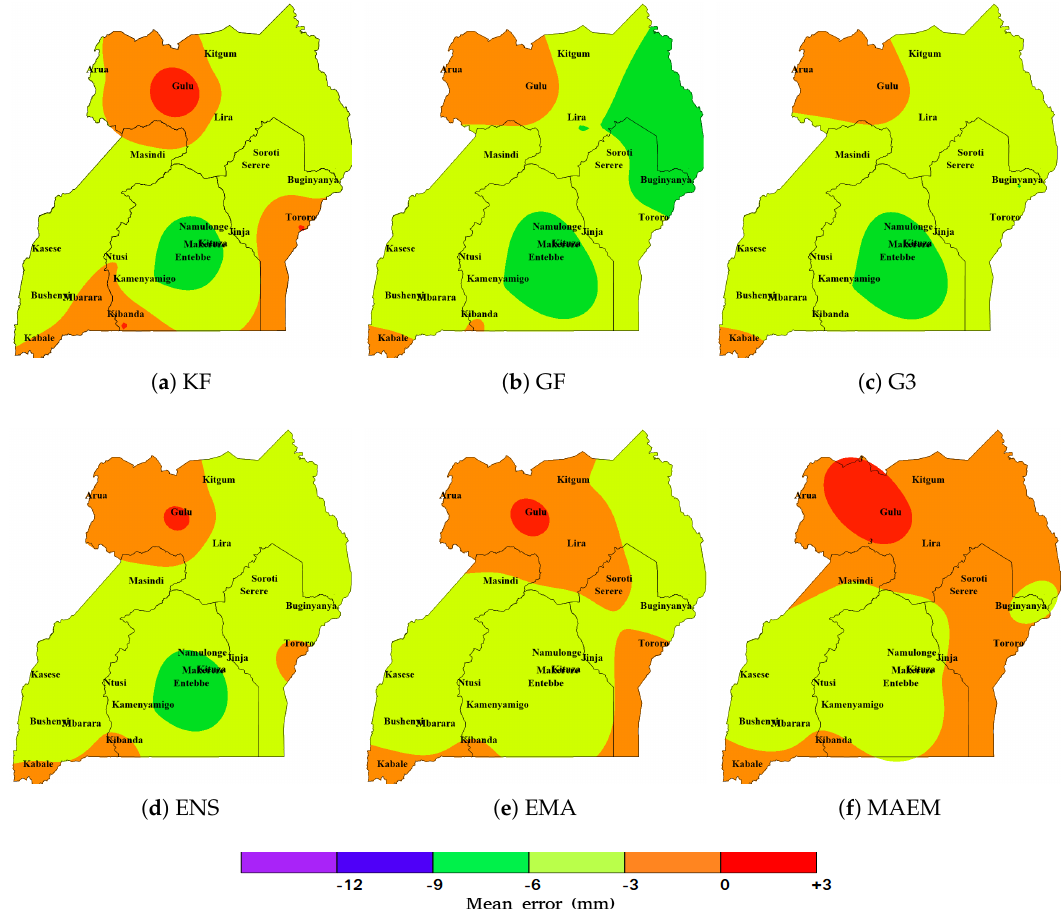
Figure 5. Shows the spatially interpolated mean error (ME) using IDW for cumulus parameterization schemes: KF ( a ), GF ( b ), G3 ( c ) and the ME of the ensemble methods: ENS ( d ), EMA ( e ) and